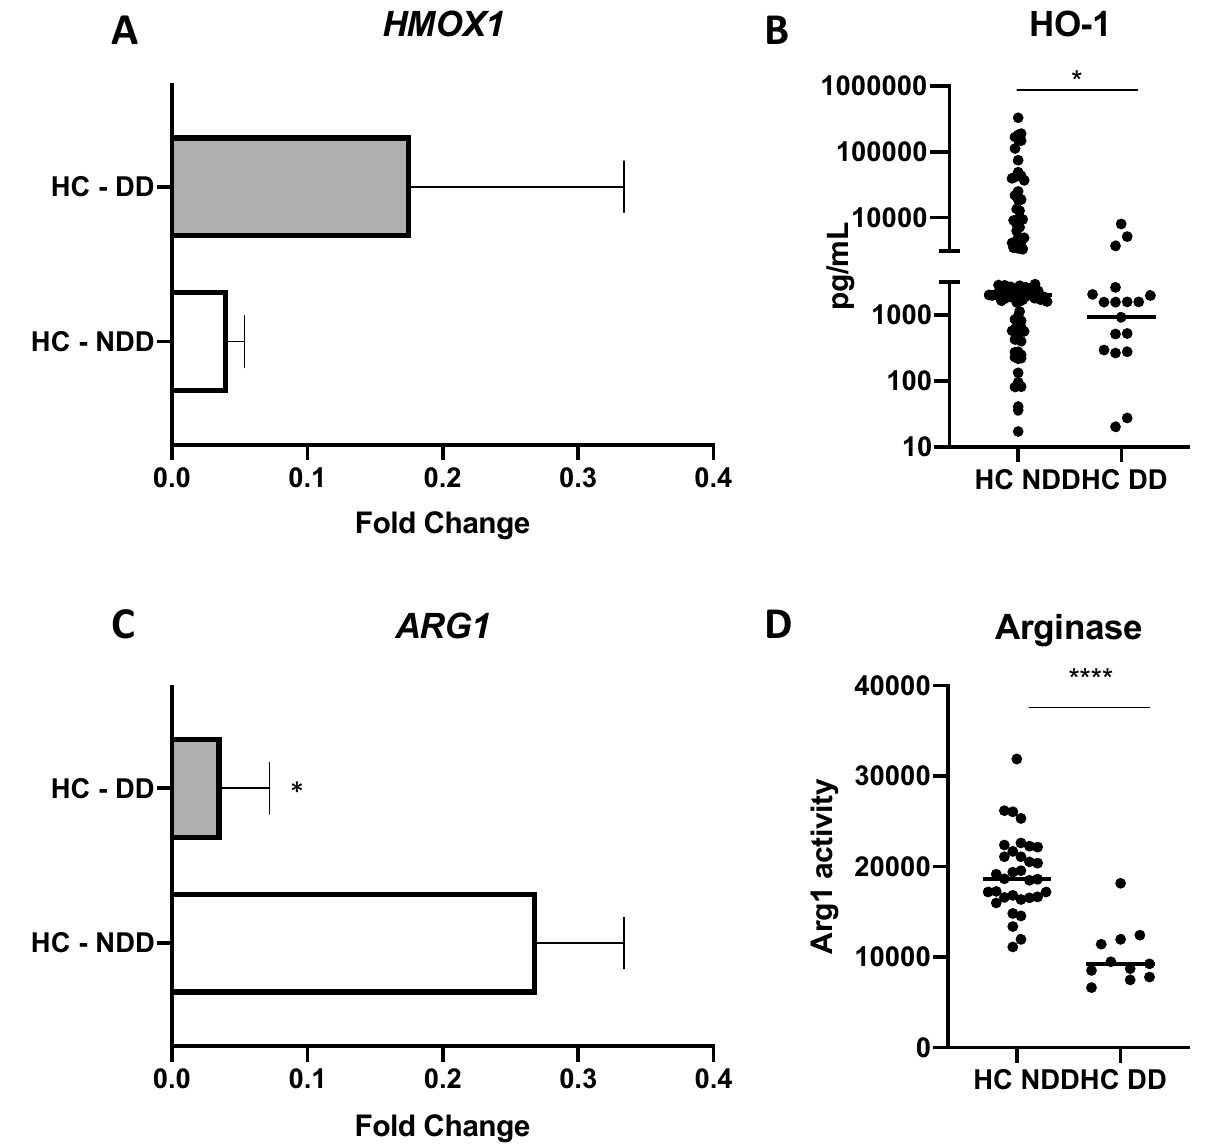
Figure 2. Arginase activity is associated with protection against leprosy in contacts. Whole blood cells and serum from 141 contacts were evaluated. Of these contacts, 33 developed leprosy during the follow-up (HC- DD). HC-NDD, household contacts that did not develop disease. ( A ) HMOX1 expression, ( B ) HO-1 levels in sera, ( C ) ARG1 expression and, ( D ) arginase activity. * p ≤ 0.05, **** p ≤ 0.0001.